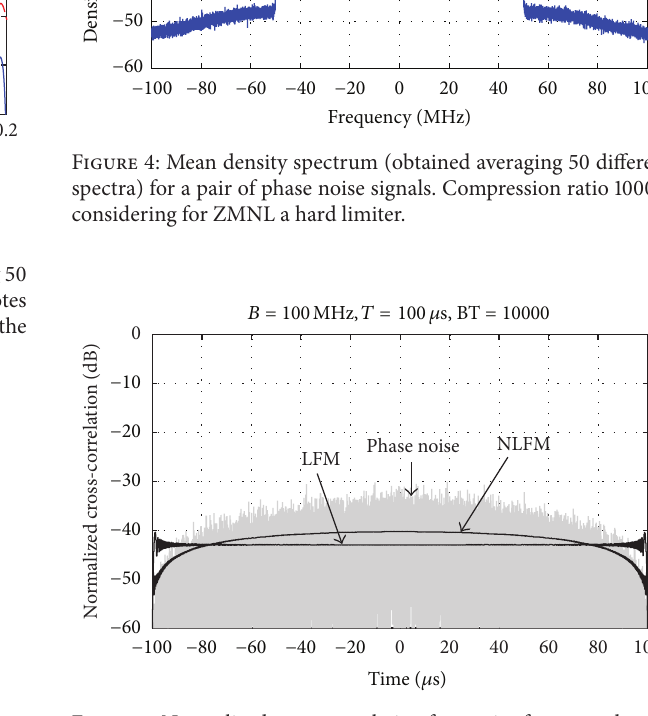
Figure 5: Normalized cross-correlation for a pair of generated noise phase signals by the iterative algorithm considering for ZMNL a hard limiter. Compression